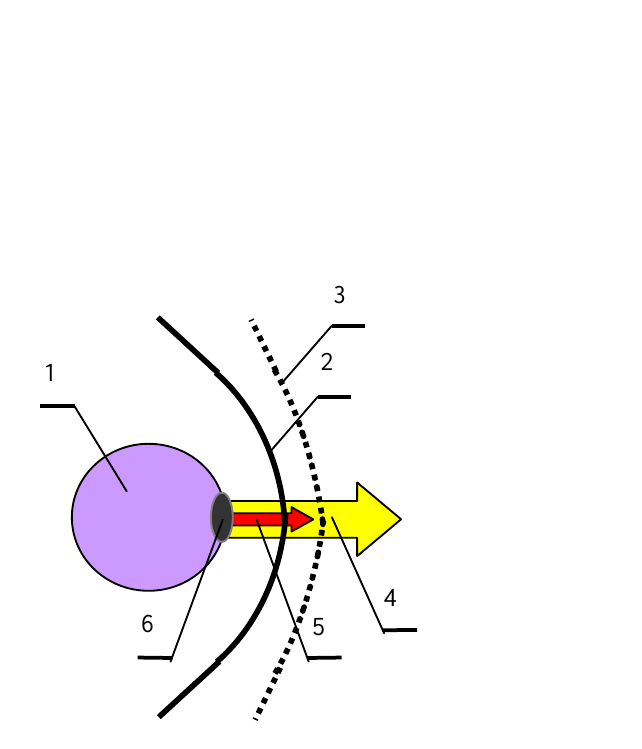
Figure 4 – General scheme of injection of the coolant into the front hemisphere: 1 – AES; 2 – shock wave before the injection of the coolant; 3 – after the injection of the coolant; 4 – speed of AES movement; 5 – speed of the injection of the coolant; 6 – hole for the injection of the